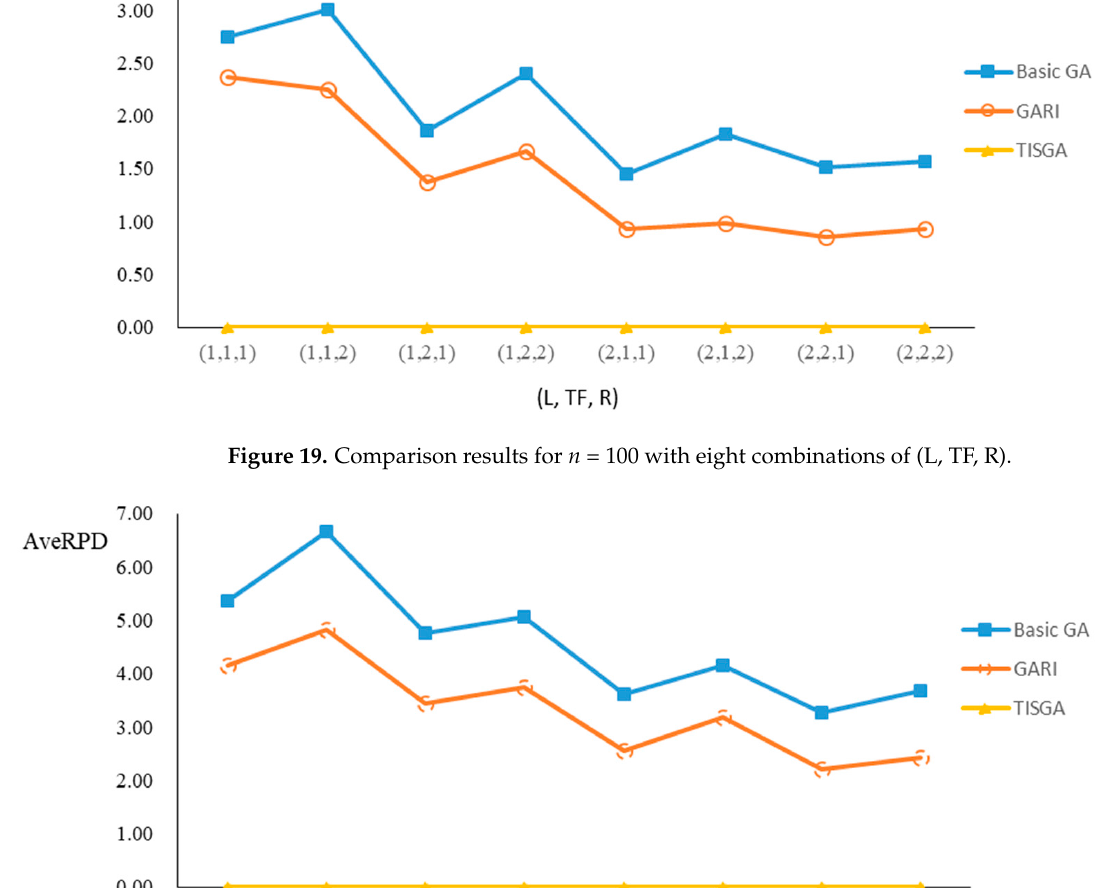
Figure 20. Comparison results for n = 200 with eight combinations of (L, TF, R).